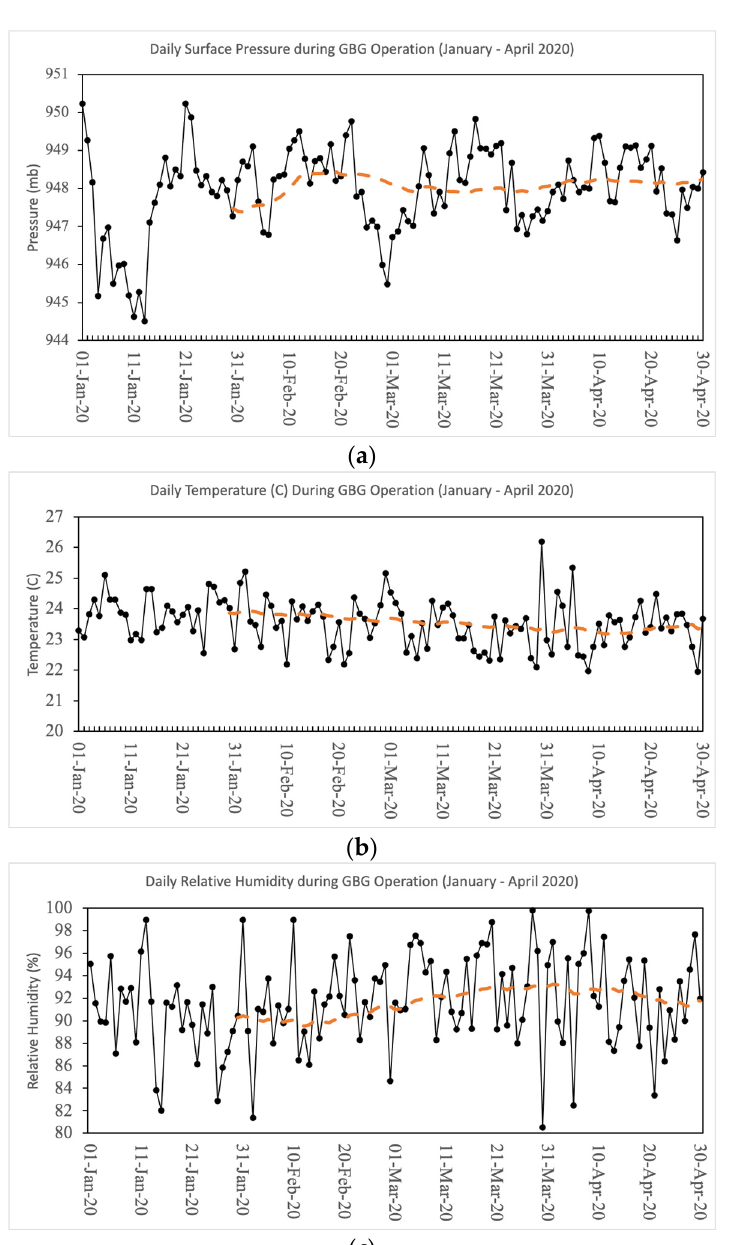
Figure A3. ( a ) Daily surface pressure during GBG operation (January–April 2020) with 30 days’ moving average (dashed orange line); ( b ) daily near-surface temperature during GBG operation (January–April 2020) with 30 days’ moving average (dashed orange line); ( c ) daily relative humidity during GBG operation (January–April 2020) with 30 days’ moving average (dashed orange line). All data are from ERA5 reanalysis data. Table A1. Day by day flare usage for five GBG towers during the 2020 weather modification oper-